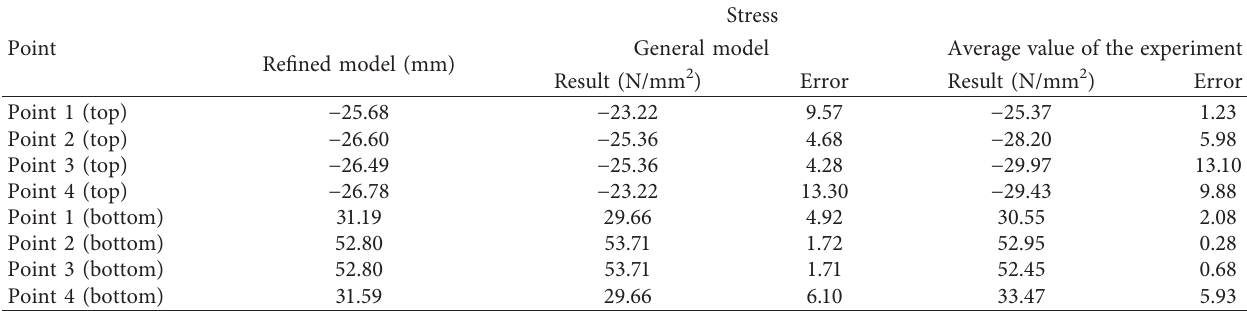
Table 4: Comparison of the stresses between the experiment and FE